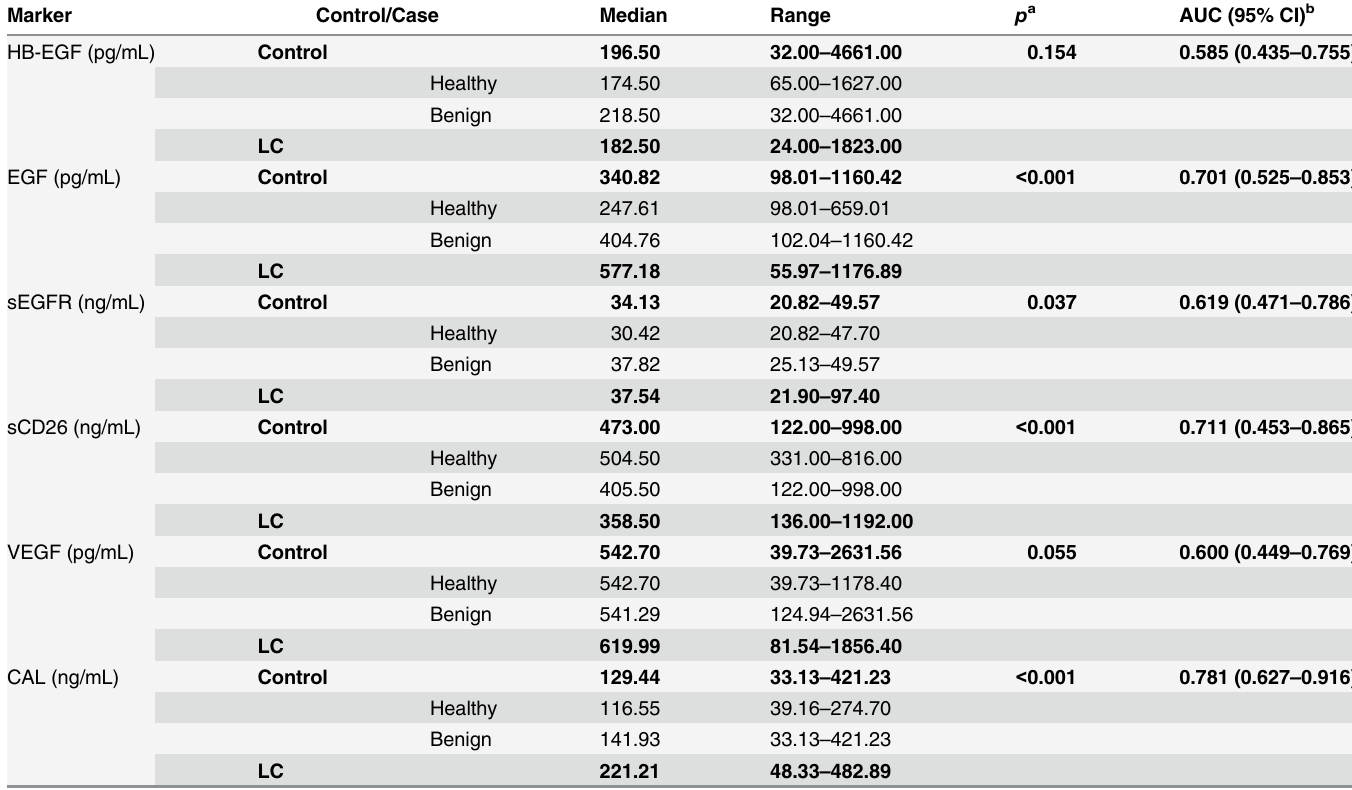
Table 1. Distribution of markers in serum of Lung Cancer patients and Controls, and efficacy in classifying Lung Cancer. Marker